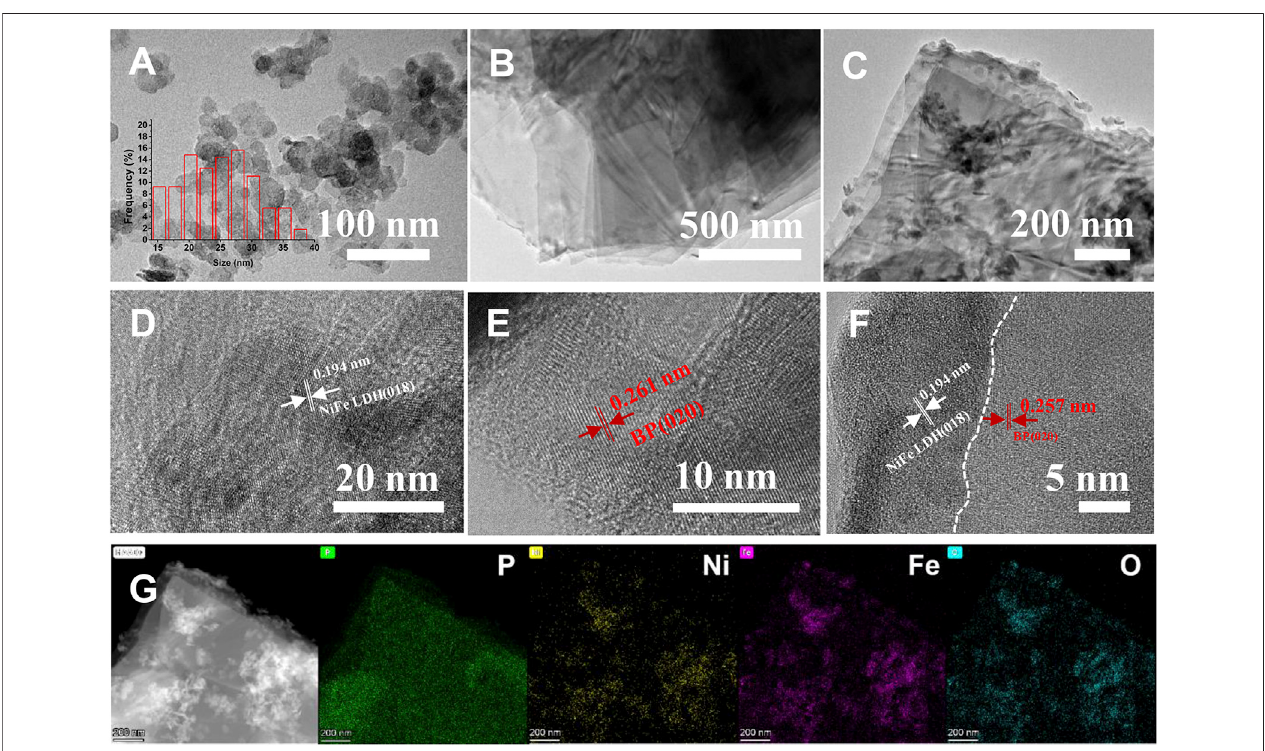
FIGURE 2 | (A) TEM image of NiFe-LDH (inset is the histogram of lateral size distribution), (B) high-resolution transmission electron microscope (HRTEM) image of NiFeLDH, (C) TEM image ofEBP nano fl akes, (D) HRTEM image ofEBP, (E) TEM image of NiFeLDH@EBP, (F) HRTEM image of NiFeLDH@EBP and its corresponded distance of crystal planes, and (G) HAADF-STEM image and EDS element mapping images of P, Ni, Fe, and elements.